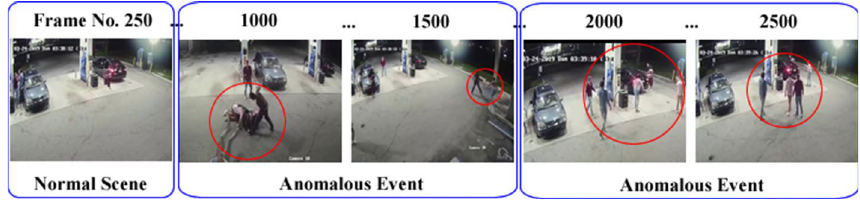
The ground-truth are manually labeled through manual inspection frame-by-frame. The events are occurring from frame no. 500 to 1500, then continuing from frame no. 2300 to 2500. The corresponding accuracies of anomalous segments are provided in Table 5.